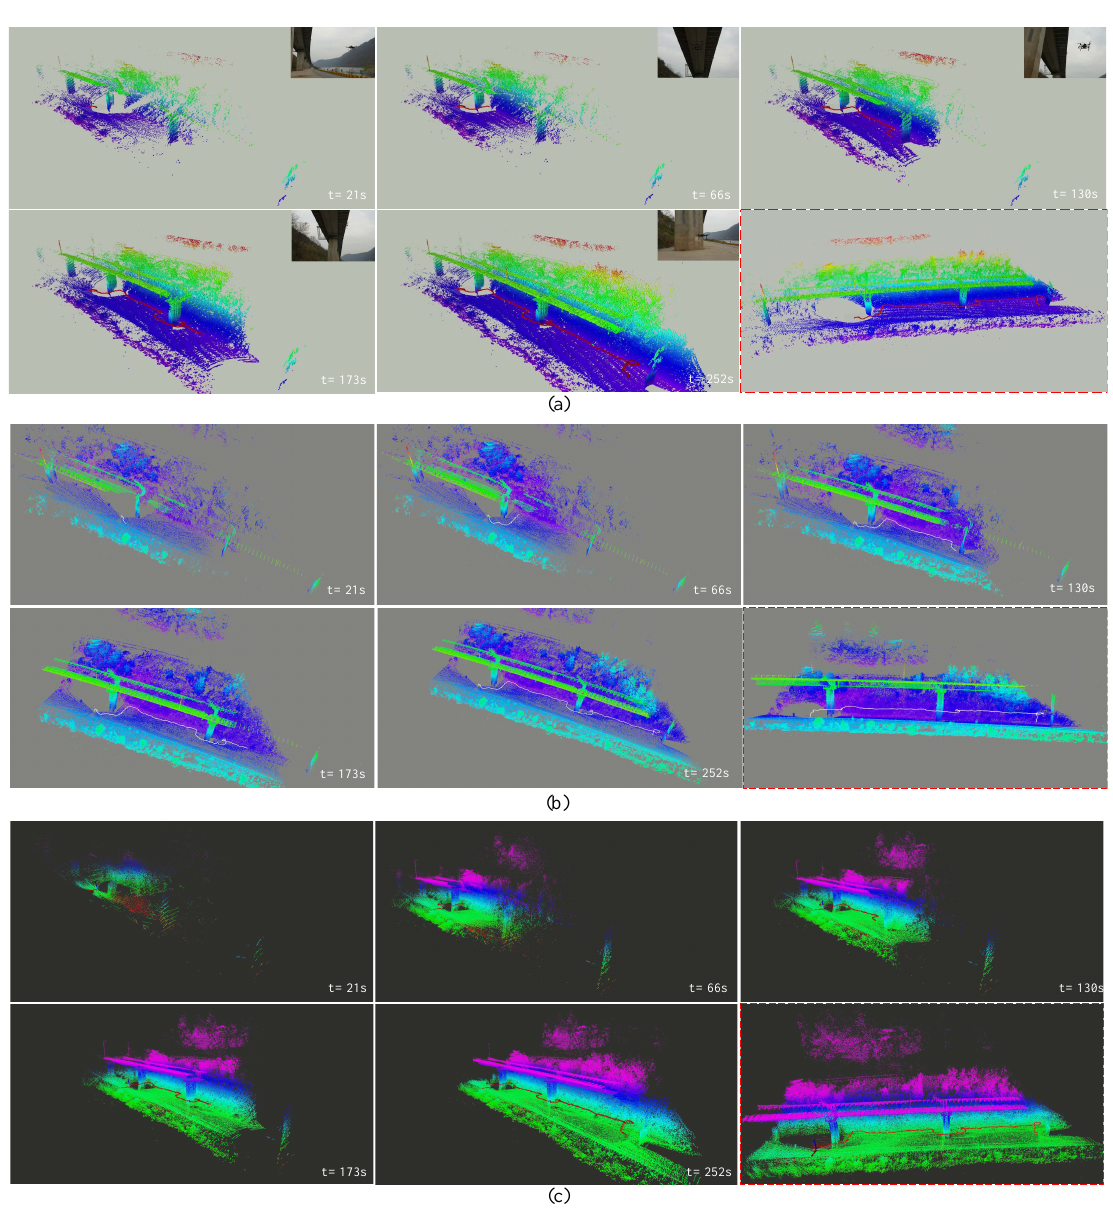
Figure 9. Experimental results obtained using different methods at Deungseon Bridge for a simple straight path: our method vs. LiDAR odometry and mapping (LOAM) vs. LIO-mapping. ( a ) Results of the proposed method: The solid red line represents the estimated trajectory of the UAV. The lower right image is the final map. ( b ) Results of LOAM: The solid white line represents the estimated trajectory of the UAV. The lower right image is the final map. ( c ) Results of LIO-mapping: The solid red line represents the estimated trajectory of the UAV. The lower right image is the final